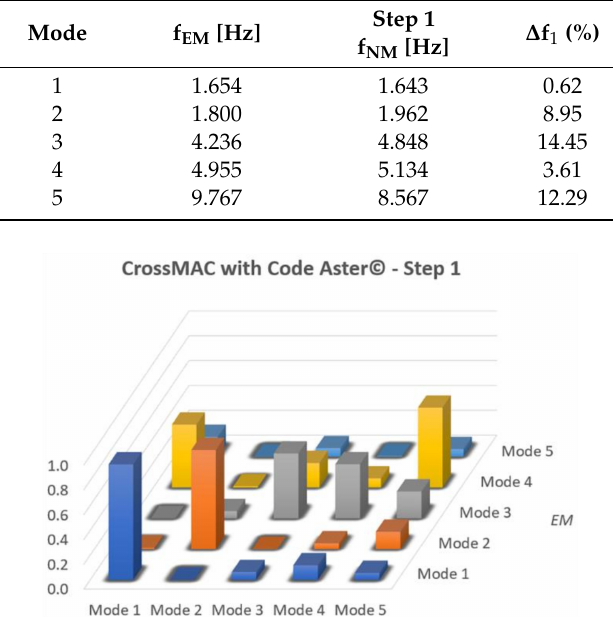
Table 4. Comparison between EM and NM frequencies at step 1 with Code Aster © .